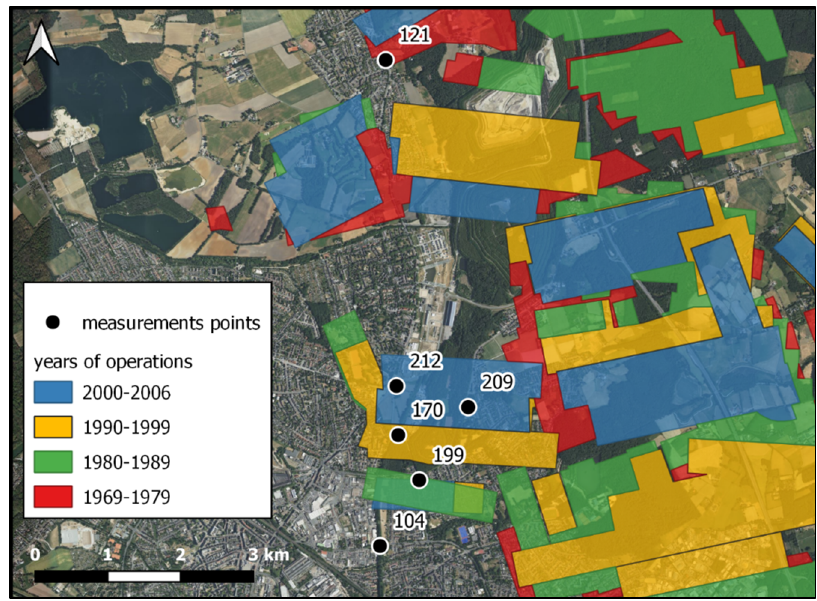
Figure 4. Map of the Lohberg mine area with the location of the measurement points selected for the analysis and exploitation carried out.